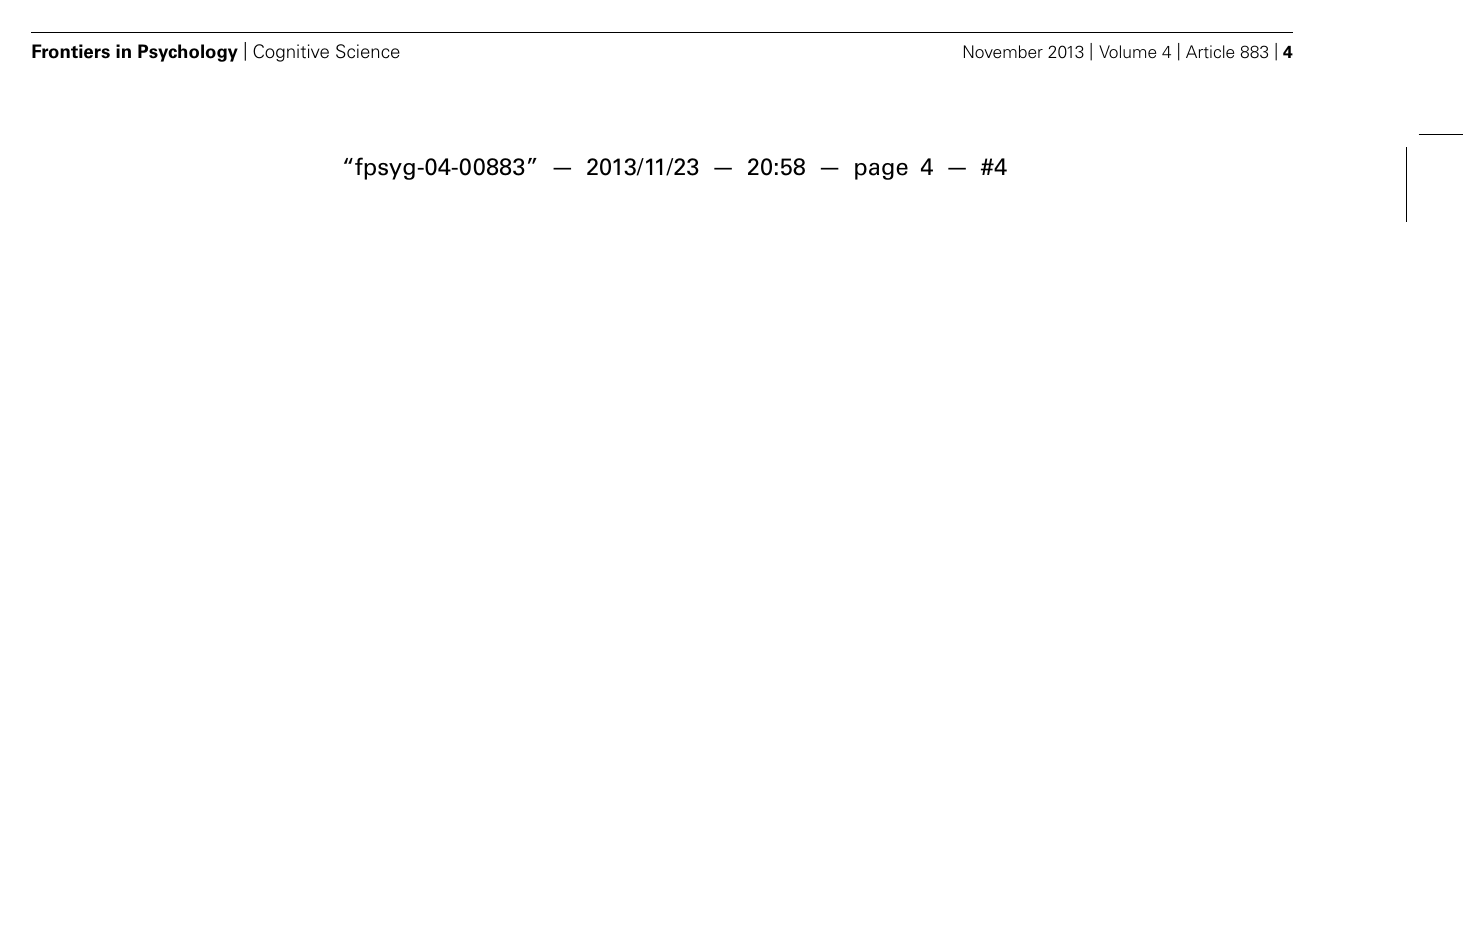
Frontiers in Psychology | Cognitive